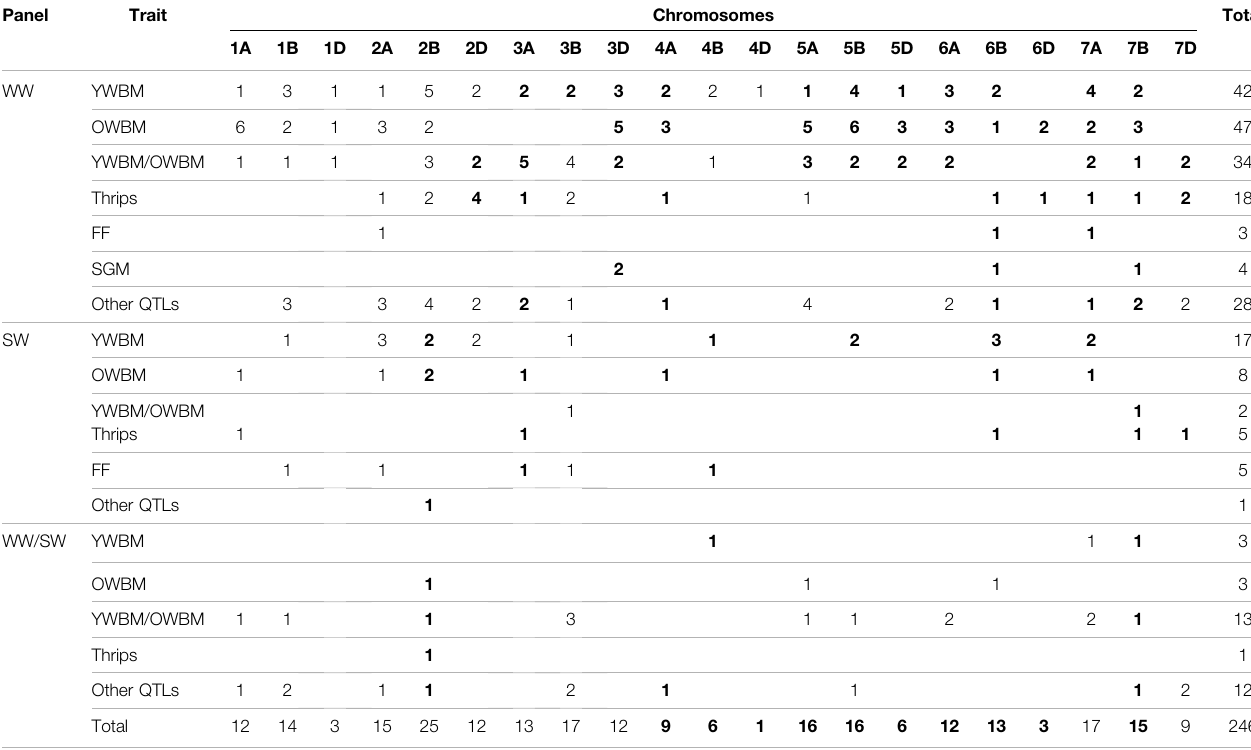
TABLE 4 | QTL distribution of insect resistance in either winter (WW) or spring (SW) wheat panel or both (WW/SW). Panel Trait